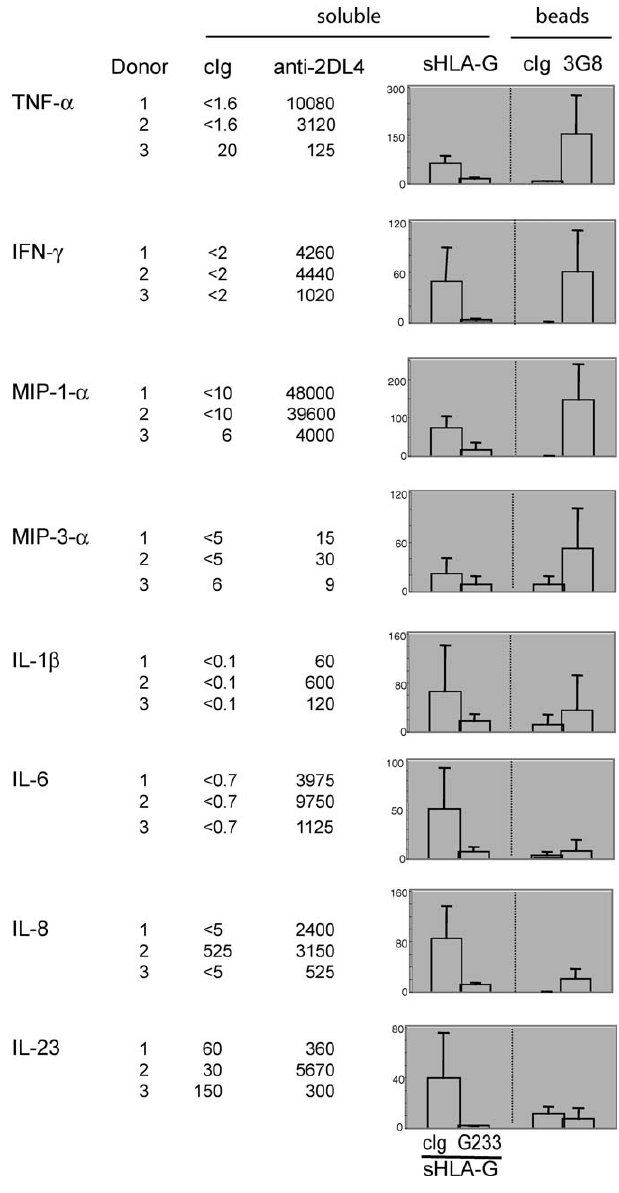
Figure 11. Cytokine/Chemokine Synthesis Induced by Soluble HLA-G in Resting NK Cells Resting NK cells (5 3 10 5 cells/well) from three different donors were incubated separately for 48 h with either soluble, control IgM Ab (cIg), soluble anti-KIR2DL4 IgM mAb 36 (anti-2DL4), soluble HLA-G produced in CHO cells (sHLA-G), or beads coated with control anti-HA IgG1 mAb 16B12 (cIg) or with anti-CD16 IgG1 mAb 3G8 (3G8), as indicated. sHLA-G was used together with control IgG2a mAb (cIg) or with anti-HLA-G IgG2a mAb G233 (G233), as indicated. Secretion of the cytokines/ chemokines listed on the left is given in pg/ml for each donor separately. Secretion induced by sHLA-G and by Ab-coated beads was compared to that induced by anti-KIR2DL4 mAb for each donor separately and is expressed as a percentage of the anti-KIR2DL4 response. The graphs represent the average 6 standard deviation from three